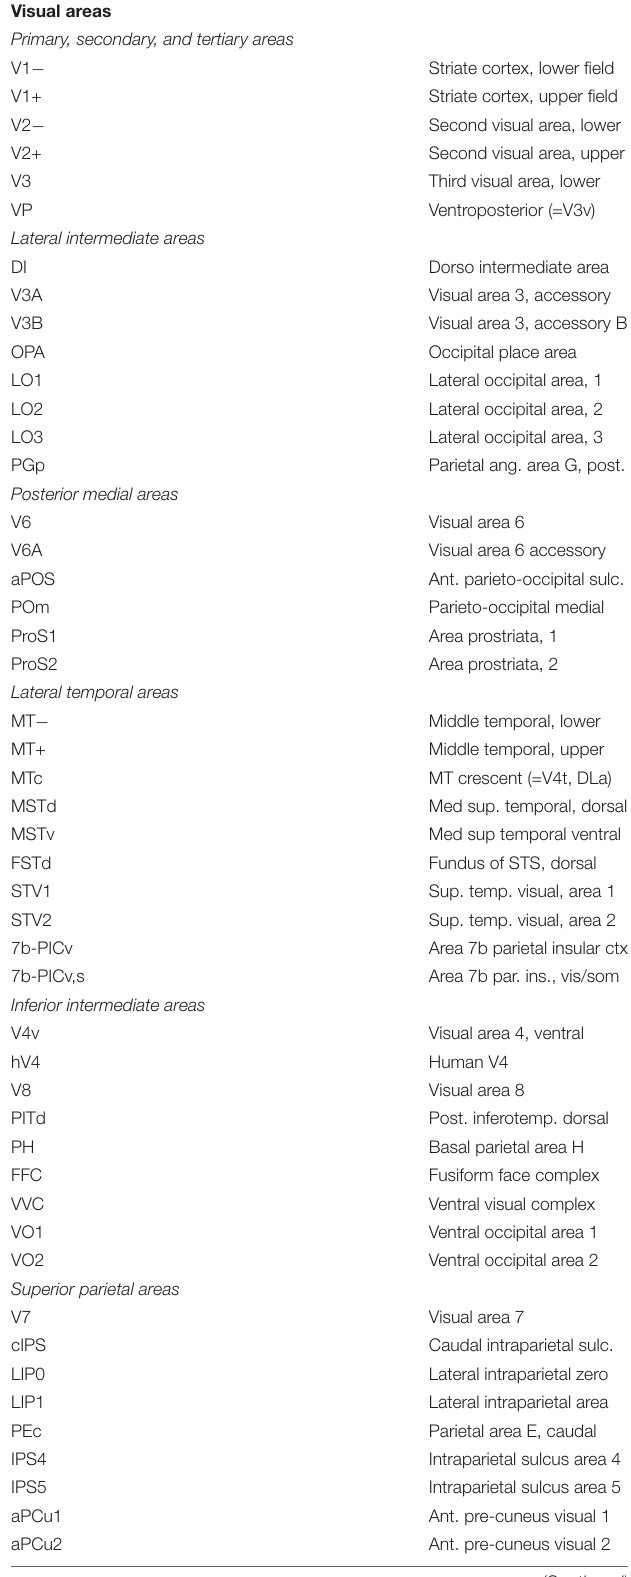
TABLE 1 | Cortical area abbreviations by modality (annotation file